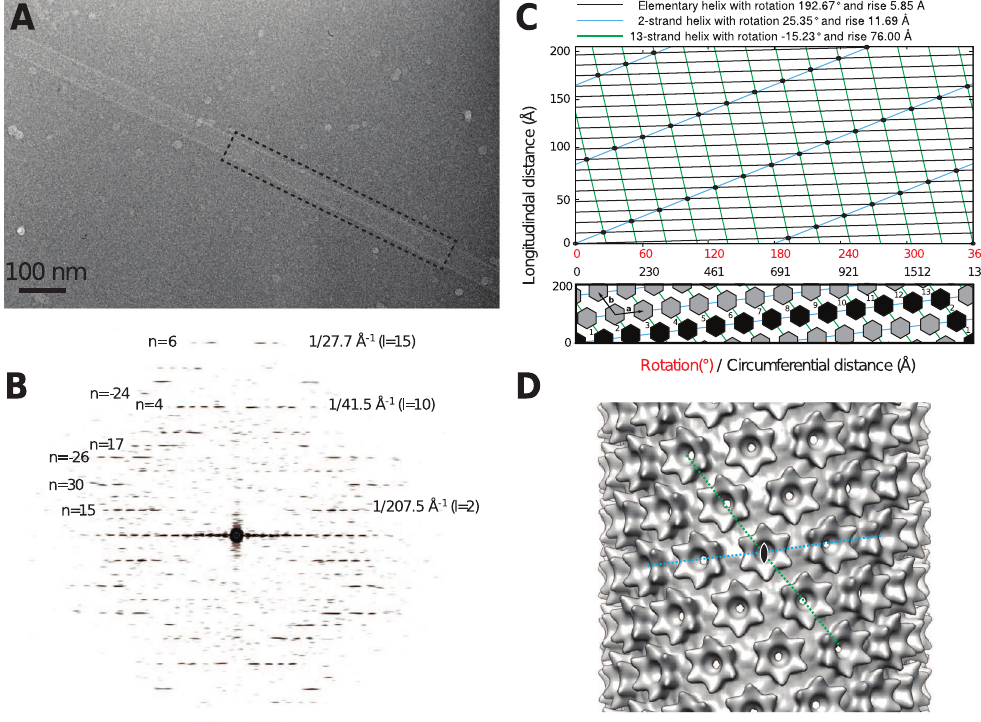
Figure 8. 3D Image Reconstruction of a single-layered RSV CA-SP tube. ( A )Cryo-EM image of the tube used for the 3D reconstruction. ( B )Power spectrum of the region outlined in (A), with some of the assigned Bessel orders (n) and layer lines (l) indicated. Clear layer lines are visible up to ~1/27.7 Å − 1 . ( C )The surface lattice of the tube and the relationship between helical symmetry descriptions. The tube is created by a regular array of CA hexamers, arranged on a cylindrical surface. The diagrams represent radial projections of the structure, which corresponds to an unwrapping operation on the tube. The top panel illustrates the description of the helical lattice in terms of an elementary helix, a 2-strand helix, or a 13-strand helix. The scale for the vertical distance in this panel is expanded, for clarity. The bottom panel illustrates the description in terms of the generating vectors, a and b , of a near hexagonal 2D lattice, and the circumferential vector 13 a - 2 b . The black highlighting shows the components of the circumferential vector. The circumferential distance is calculated assuming a tube radius of 220 Å. ( D )The final 3D reconstruction with local C6 symmetrization of the turrets applied. The view is down a 2-fold rotational symmetry axis, passing through the central hexamer. The disposition of the 2-strand and 13-strand helices shown in panel C are indicated. These coincide with the generating vectors of a near-hexagonal 2D lattice when the cylinder is